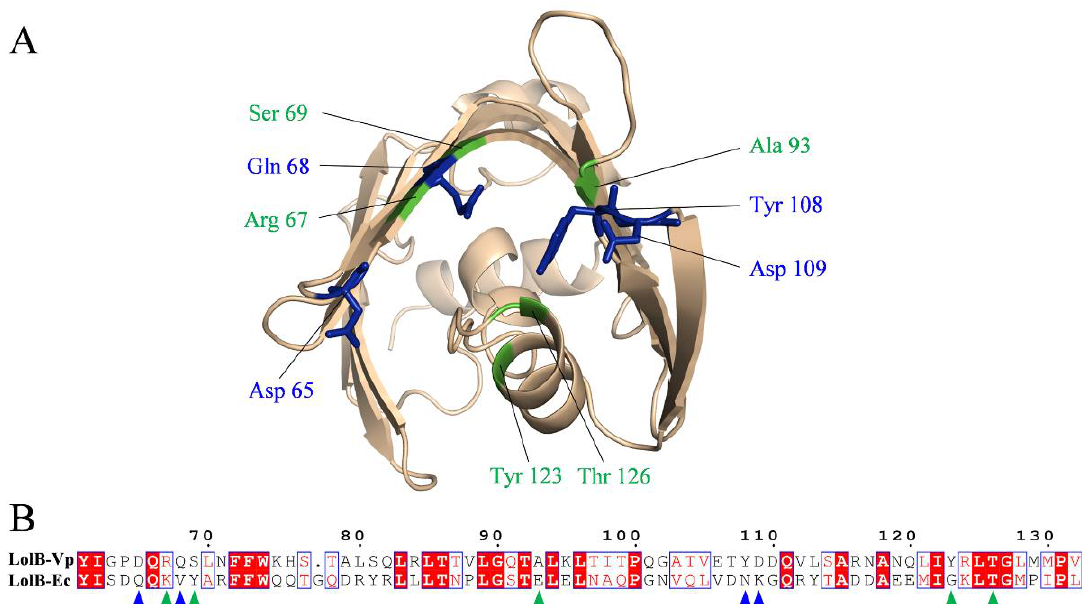
Figure 10. Amino acid residues interacting with inhibitors in V. parahaemolyticus LolB. ( A ): Position of interaction sites in V. parahaemolyticus LolB. Residues involving backbone contacts are labeled in green, and residues involving side chain interactions are shown as blue sticks. ( B ): Sequence alignment of LolB. Residues involving backbone contacts in V. parahaemolyticus LolB are indicated by green triangles, and residues involving side chain interactions in V. parahaemolyticus LolB are indicated by blue triangles. Vp, Vibrio parahaemolyticus ; Ec, Escherichia coli